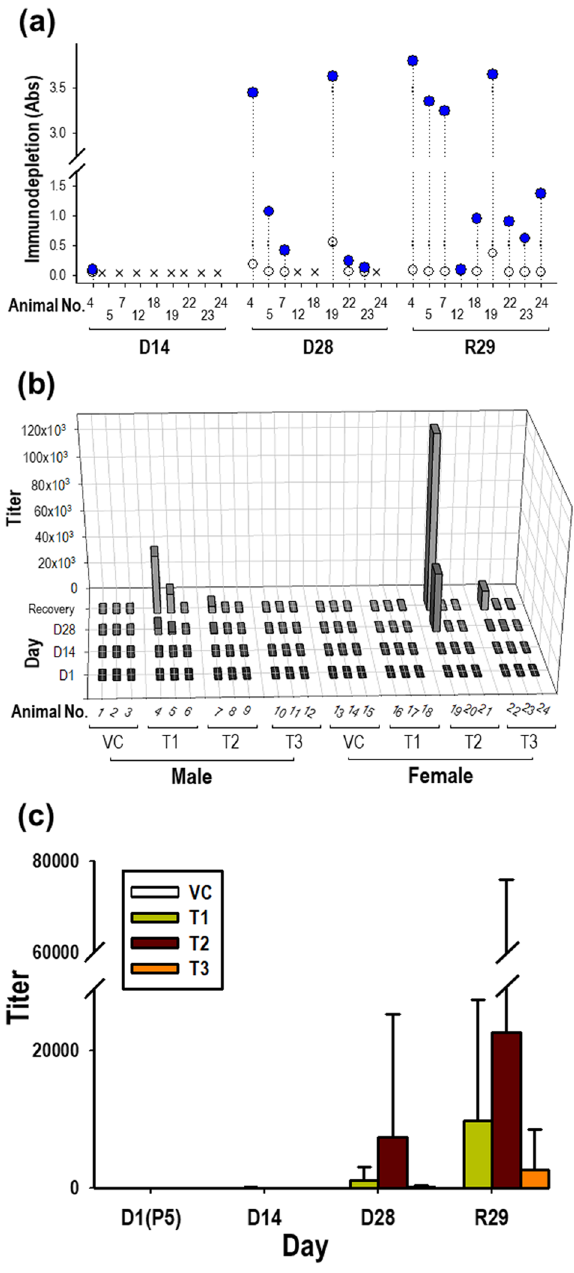
Figure 6. Measurement of ADAs, representing anti-GX-G3 antibodies, in rats subjected to 4-week repeated subcutaneous injection with GX-G3 followed by a 4-week recovery period. Rats were separated into 4 injection subgroups: VC (vehicle control), T1 (1 mg/kg GX-G3), T2 (3 mg/kg GX-G3), and T3 (10 mg/kg GX-G3). ADA levels in rat sera were measured using the method validated in the present study. ( a ) Immuno-competition assays were performed to discriminate between true and false positive samples. True positivity for GX-G3 specificity was identified based on a greater than 30% difference in absorbance between the non-treated and GX-G3-treated samples. ( b ) Rat serum samples determined to be true positives were prepared as serial three- fold dilutions beginning from 20-fold. The antibody titer of each sample was expressed as the highest fold- dilution displaying a positive response (absorbance value > normalized NCO value). ( c ) The mean antibody titer of each group was arithmetically calculated. VC, vehicle control group; P5, pre-dosing day 5; D14 and D28, dosing days 14 and 28, respectively; R29, recovery day